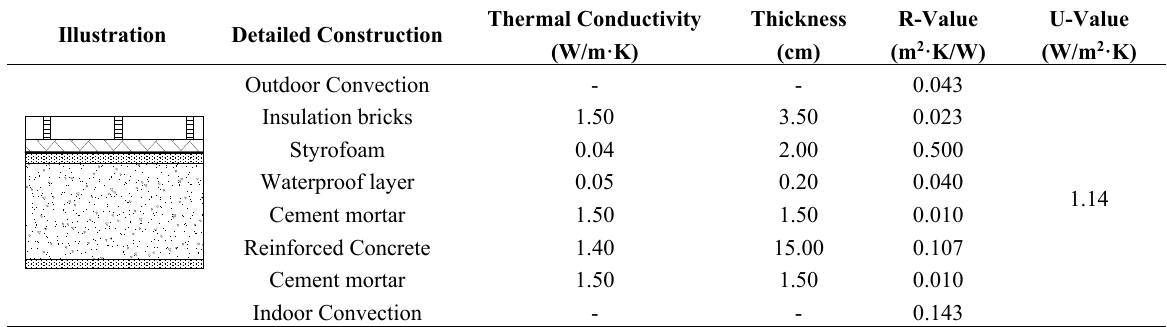
Table 4. Thermal properties of the modified RC flat